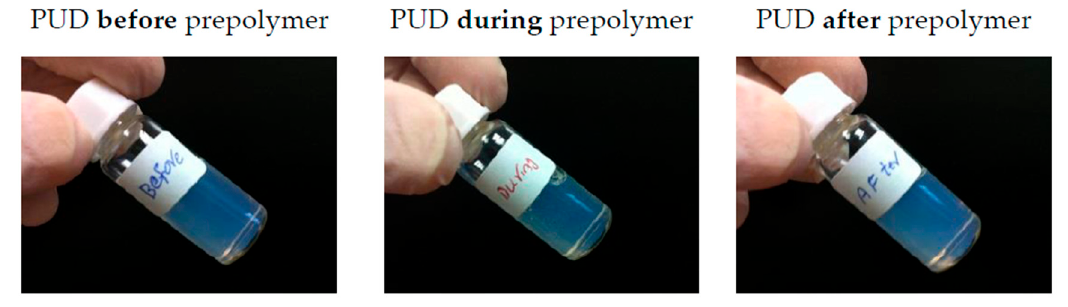
Figure 4. Scheme of T-peel test of plasticized poly(vinyl chloride (PVC)/PUD/plasticized PVC joints.